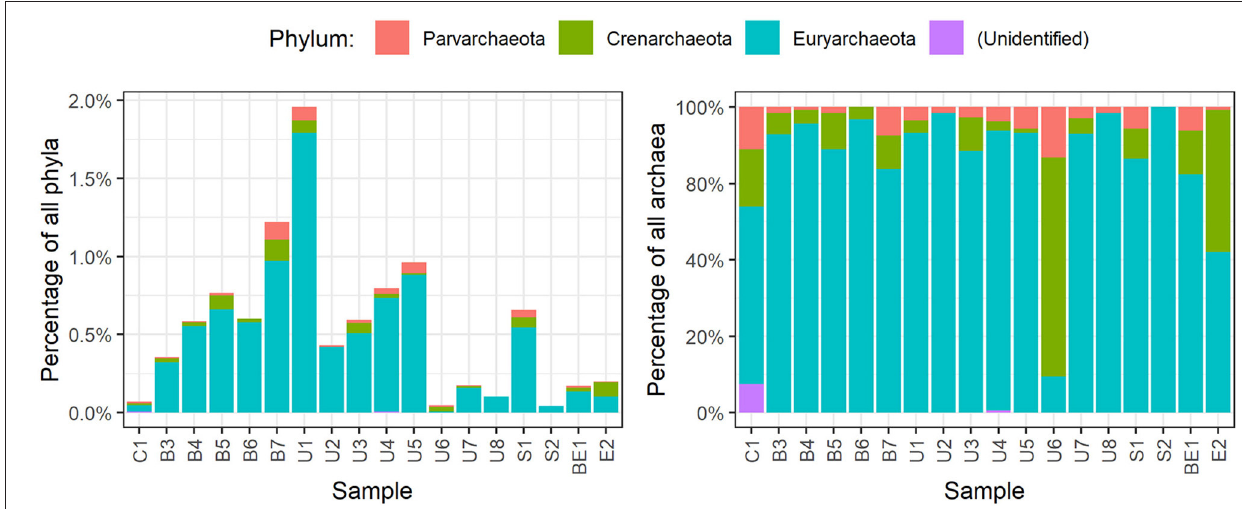
FIGURE 5 | Distribution of archaea phyla in each specimen of sediments.